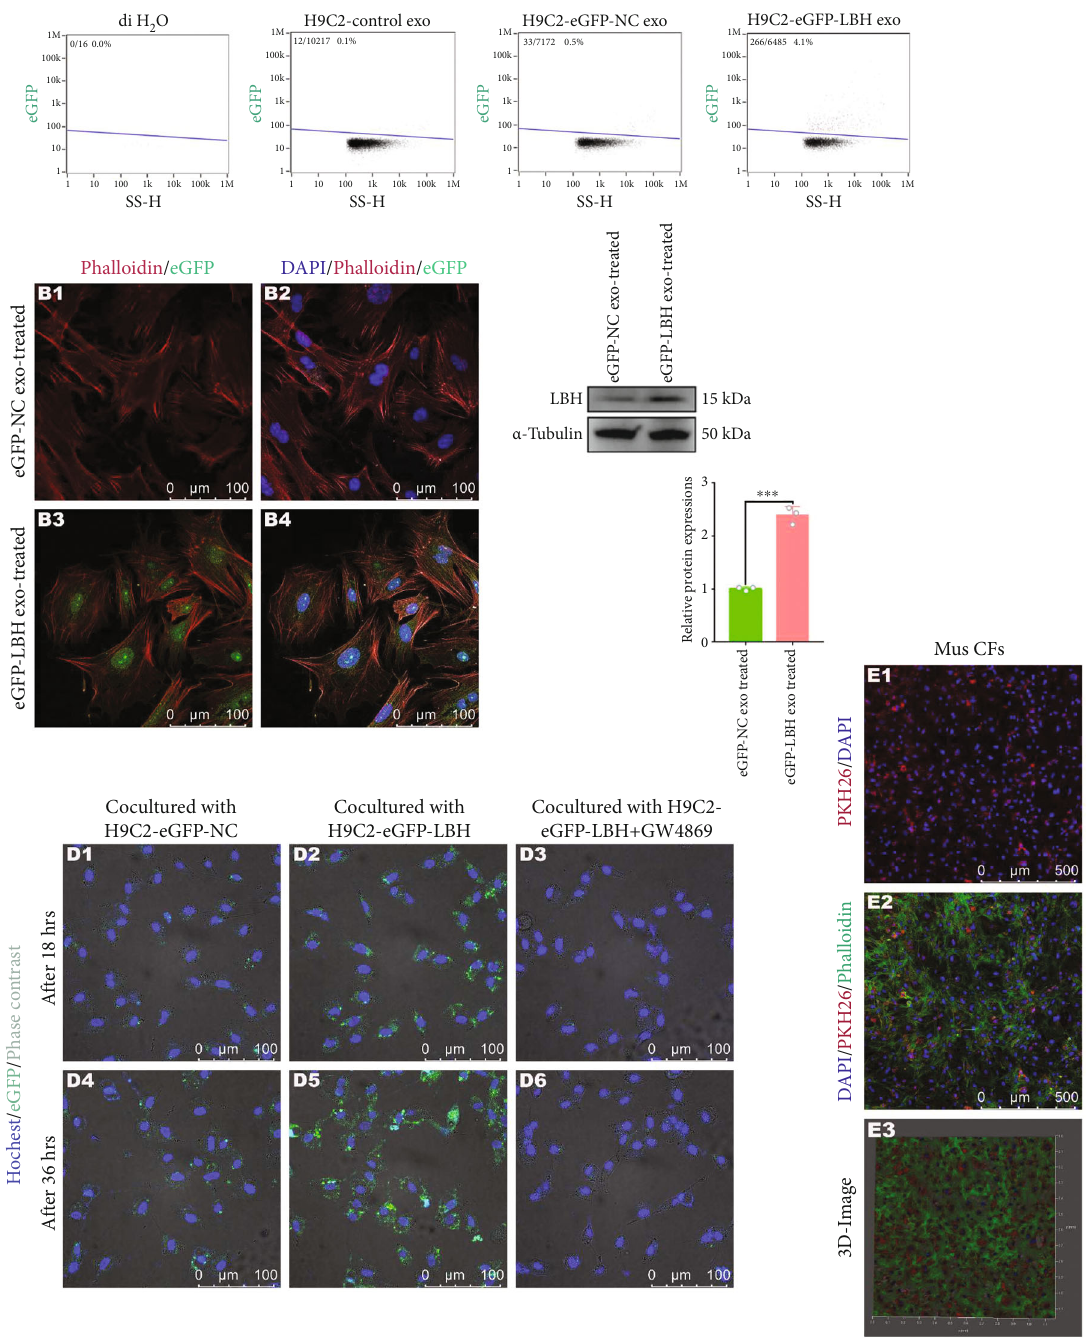
Figure 3: Cellular uptake of LBH protein from CM-derived exosomes into CFs. (a) LBH-eGFP fusion protein was detected in exosome samples derived from LBH-eGFP plasmid-transfected H9c2 cells by nano fl ow cytometry. (b) Representative confocal microscopic images of rat CFs treated with LBH-eGFP exosomes. (c) Protein levels of LBH in rat CFs treated with LBH-eGFP exosomes or NC exosomes ( ∗∗∗ p < 0 : 001 vs. CFs treated with H9c2-eGFP-NC exosomes). (d) Representative confocal microscopic images of rat CFs cocultured with LBH-eGFP plasmid-transfected H9c2 cells with or without the exosome production inhibitor GW4869. (e) Representative confocal microscopic images of mouse CFs treated with CM exosomes labeled with a PKH26